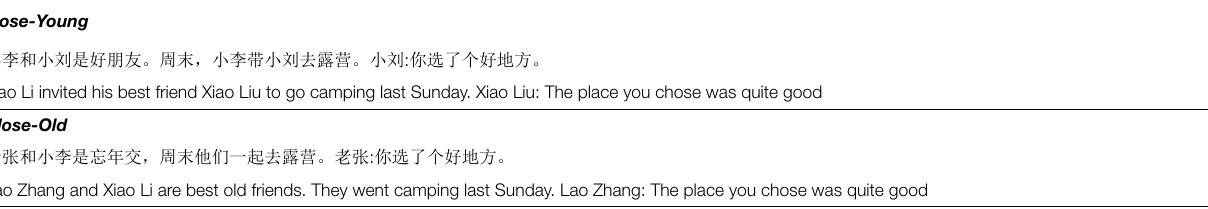
TABLE 2 | Example scenarios in Experiment 1.